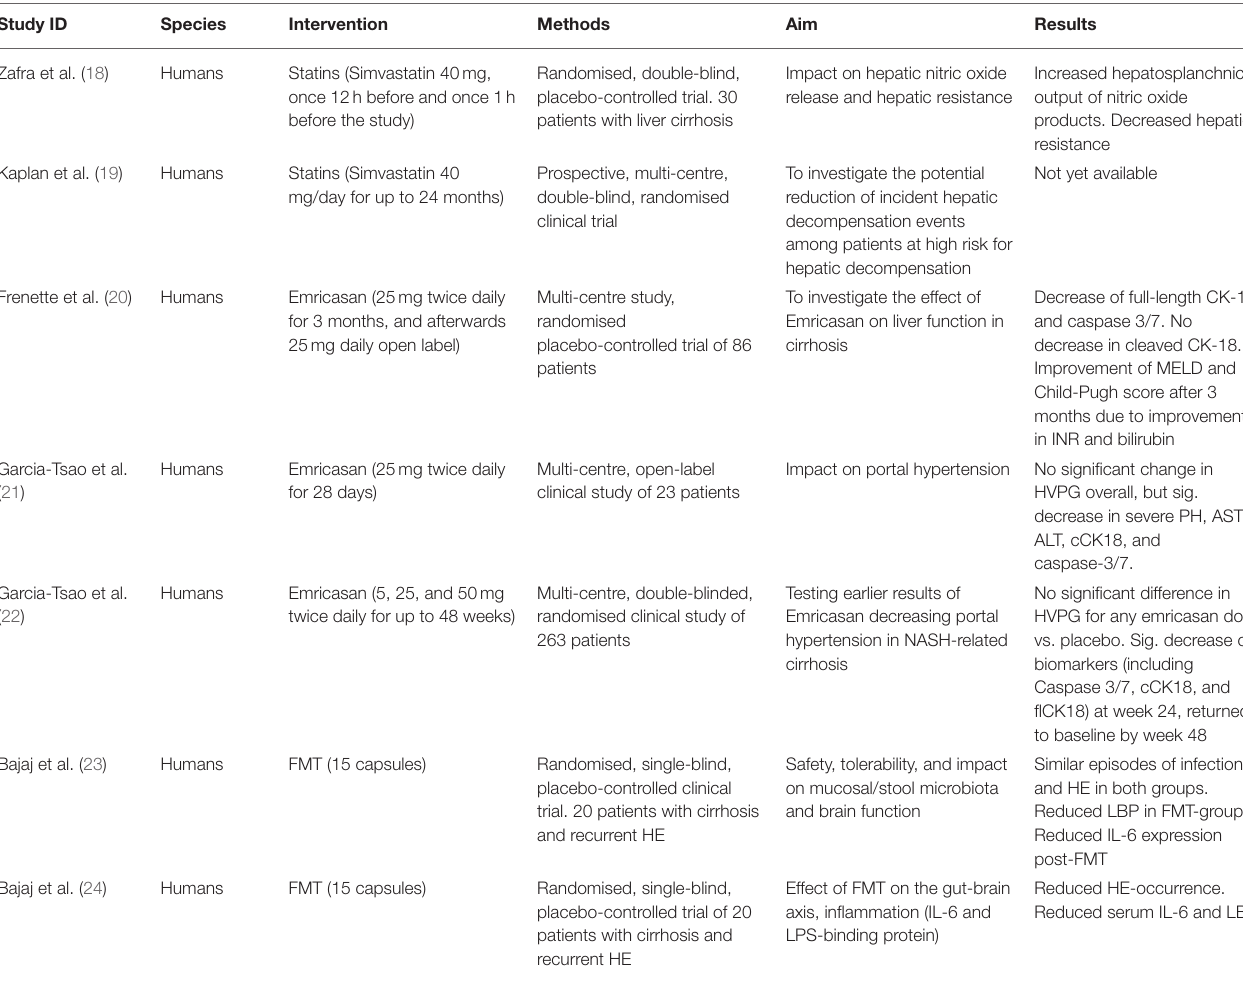
TABLE 1A | Human studies ( N =